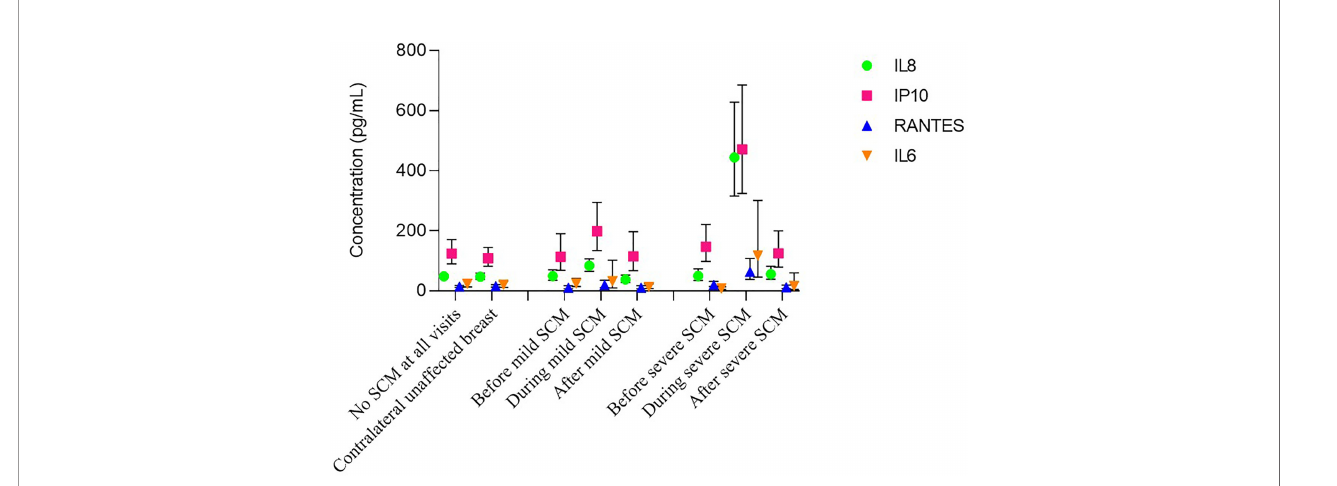
FIGURE 3 | Dynamics of cytokine concentrations during subclinical mastitis (SCM) episode.